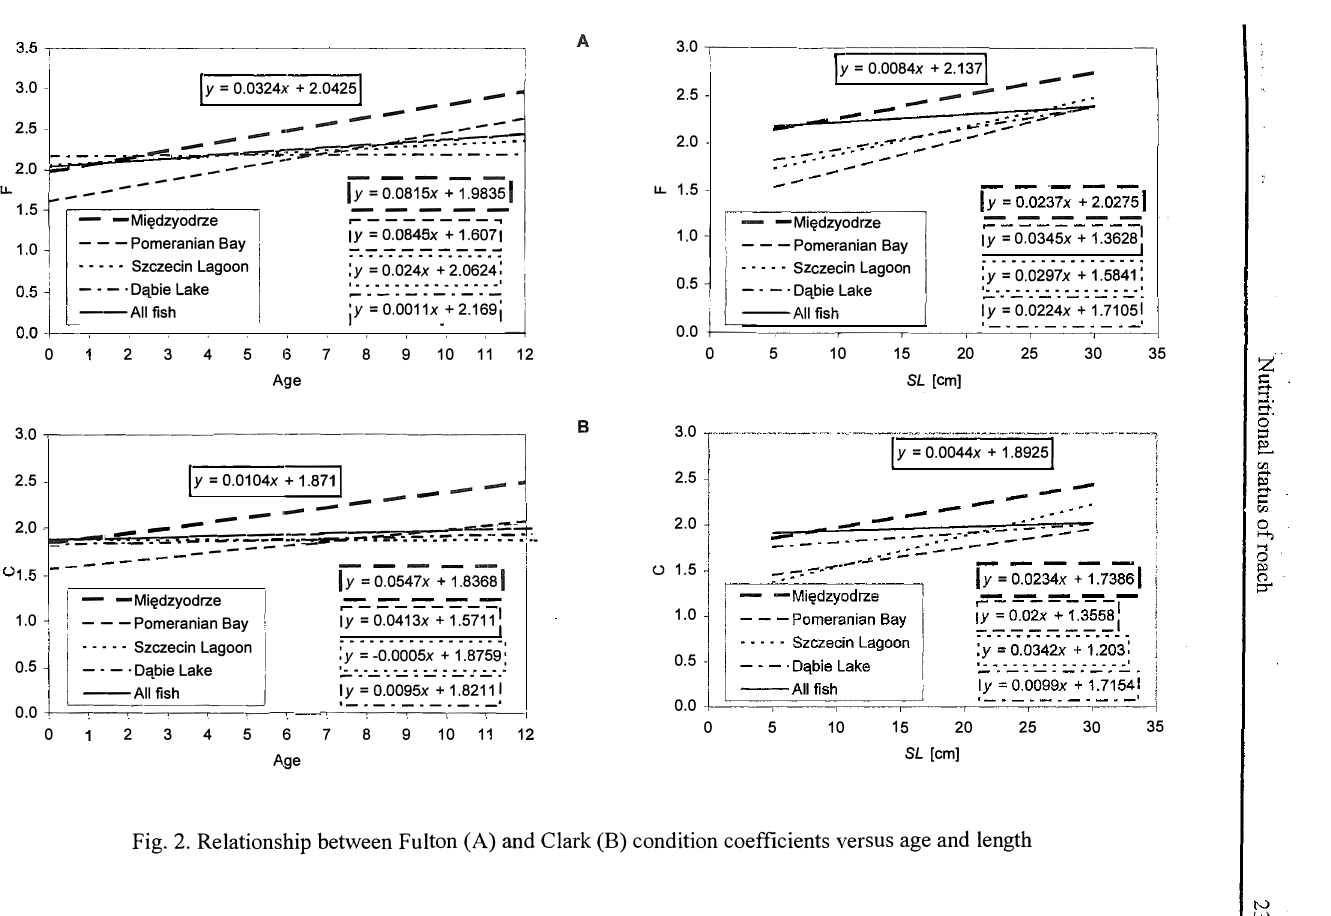
Fig. 2. Relationship between Fulton (A) and Clark (B) condition coefficients versus age and